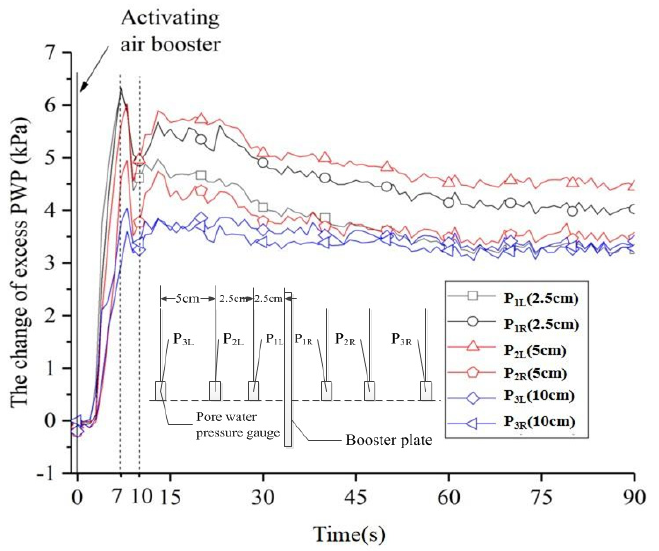
Figure 14. Time history of the excess pore water pressure during the air boosting.